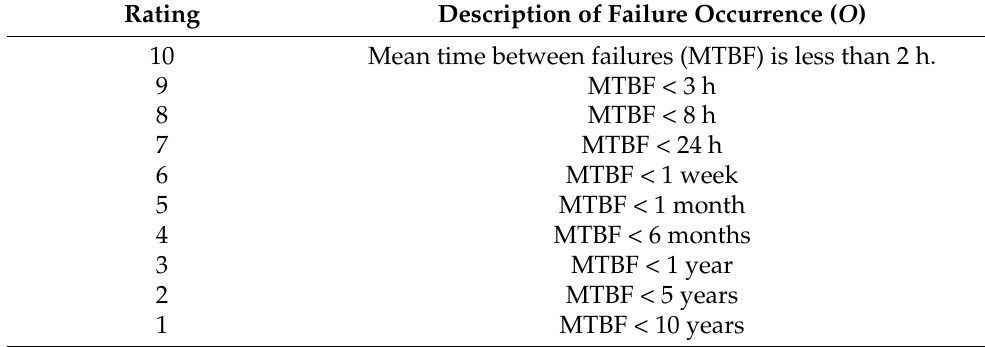
Table 2. Ratings for occurrence of a failure mode for a MASS system.